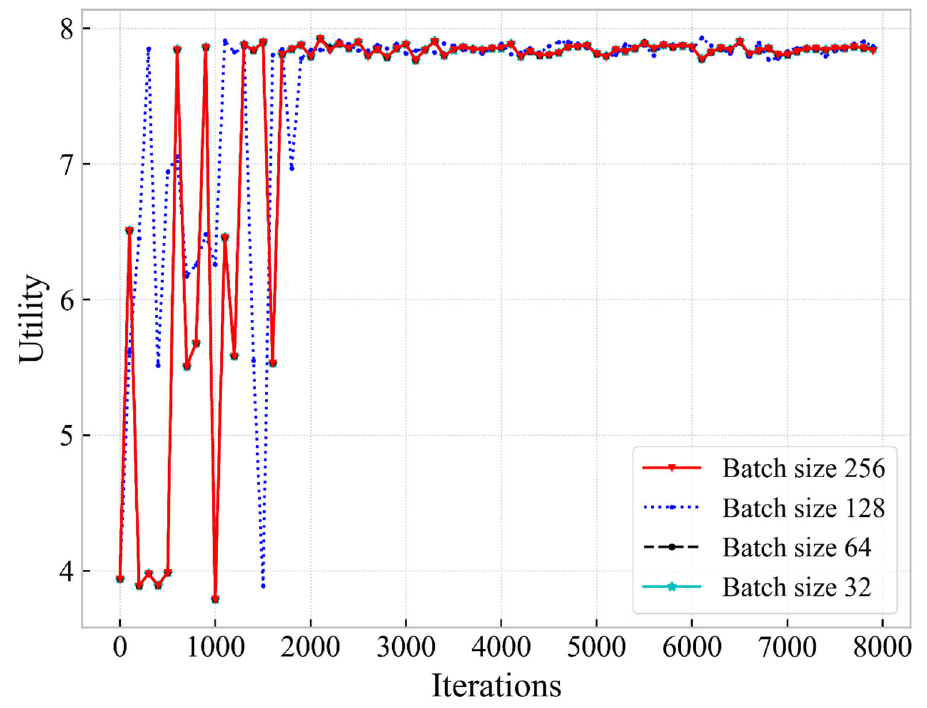
Figure 15. Comparison of algorithm performance with different batch sizes.